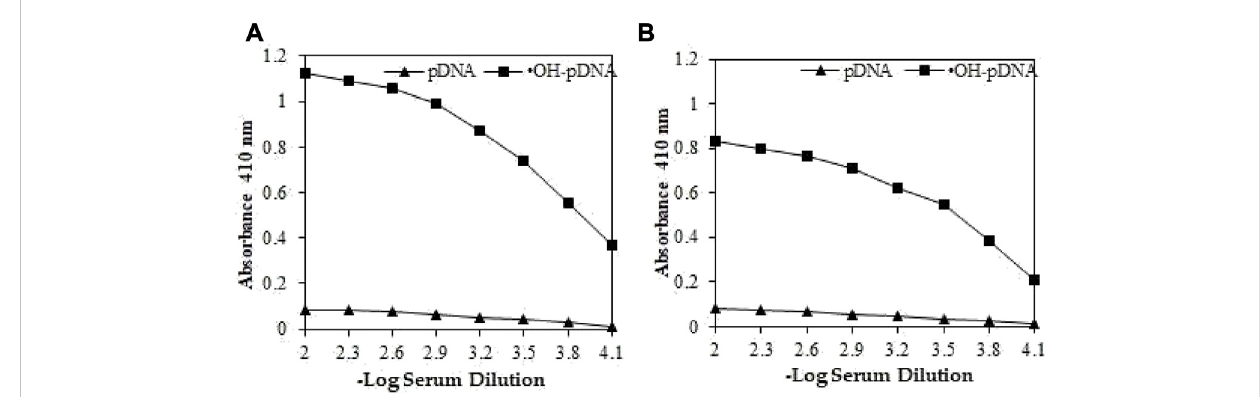
FIGURE 2 Direct binding ELISA of OH-pDNA (A) and native pDNA (B) from preimmune ( ▲ ) and immune sera ( ■ ) sera samples from immunized animals. Microtitre plates were coated with 5 μ g/mL of respective antigens.